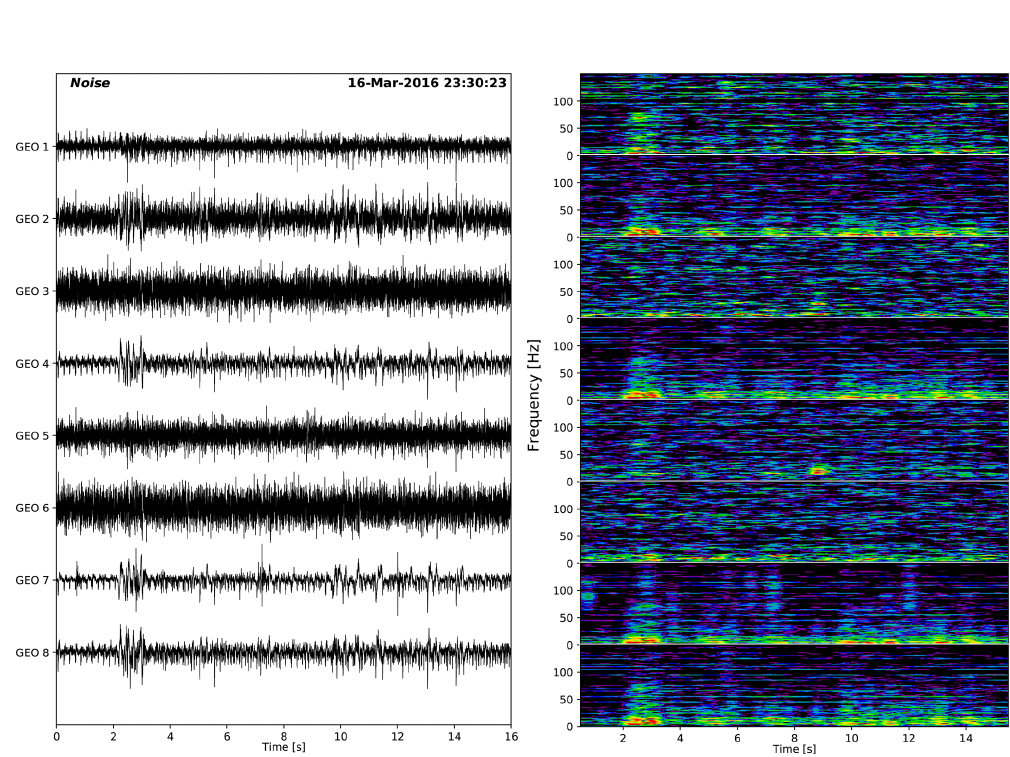
Figure B8. Example of a noise record.